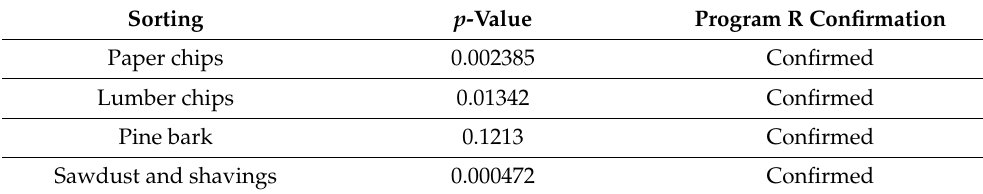
Table 2. Diebold–Mariano test results of ARIMA and WH fit.